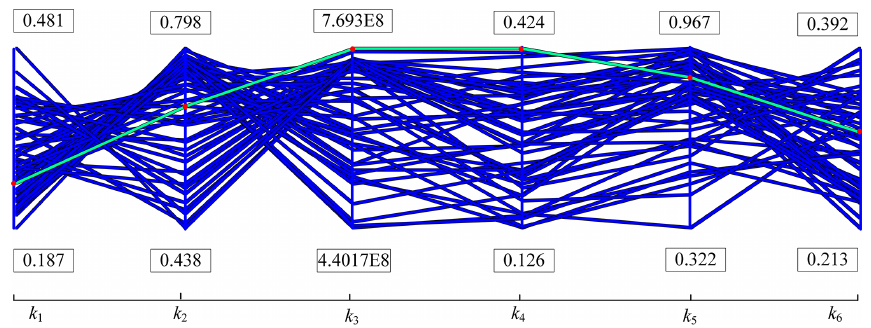
Figure 4. Multi-objective optimization design Pareto front target response value.